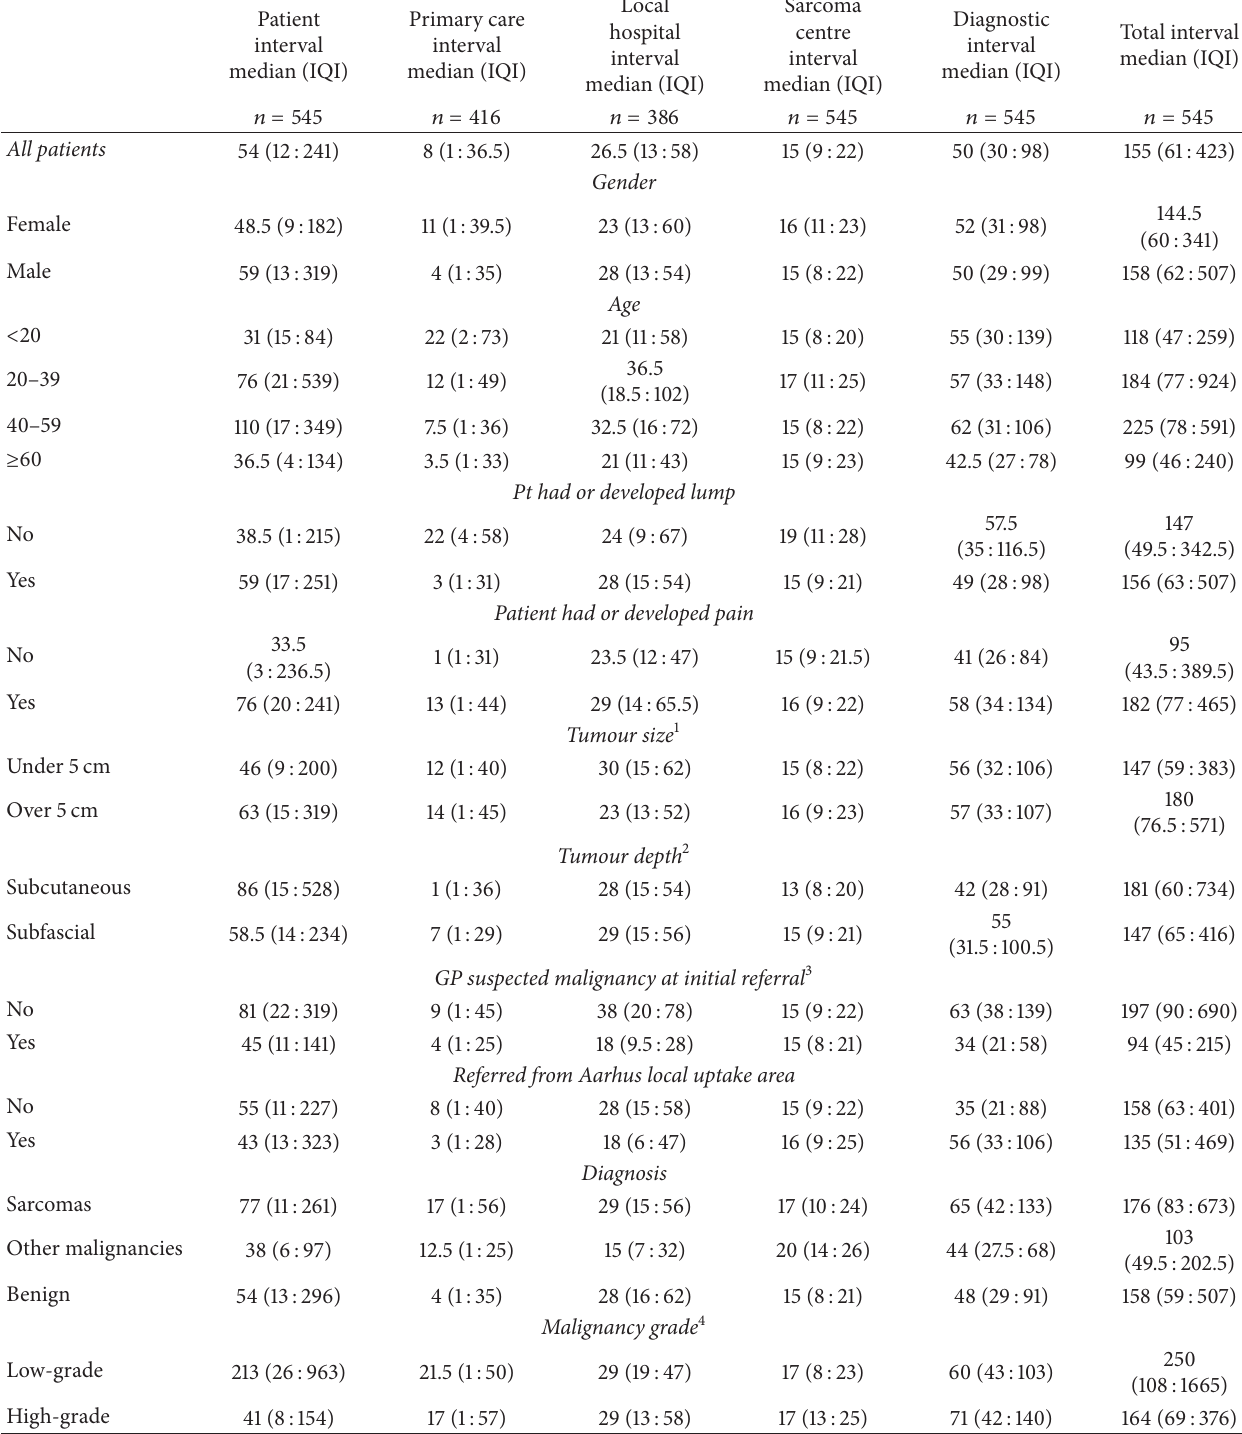
Table 5: Median number of days (interquartile intervals) spent in each interval of the diagnostic process from first symptom to decision of